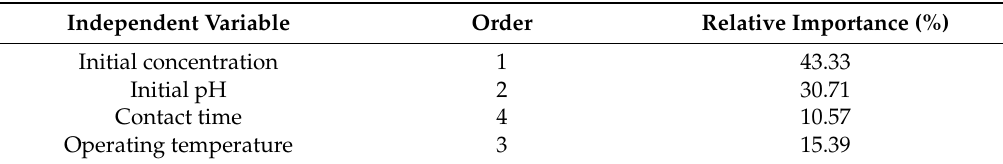
Table 4. Results from variable importance analysis in the ANN model.